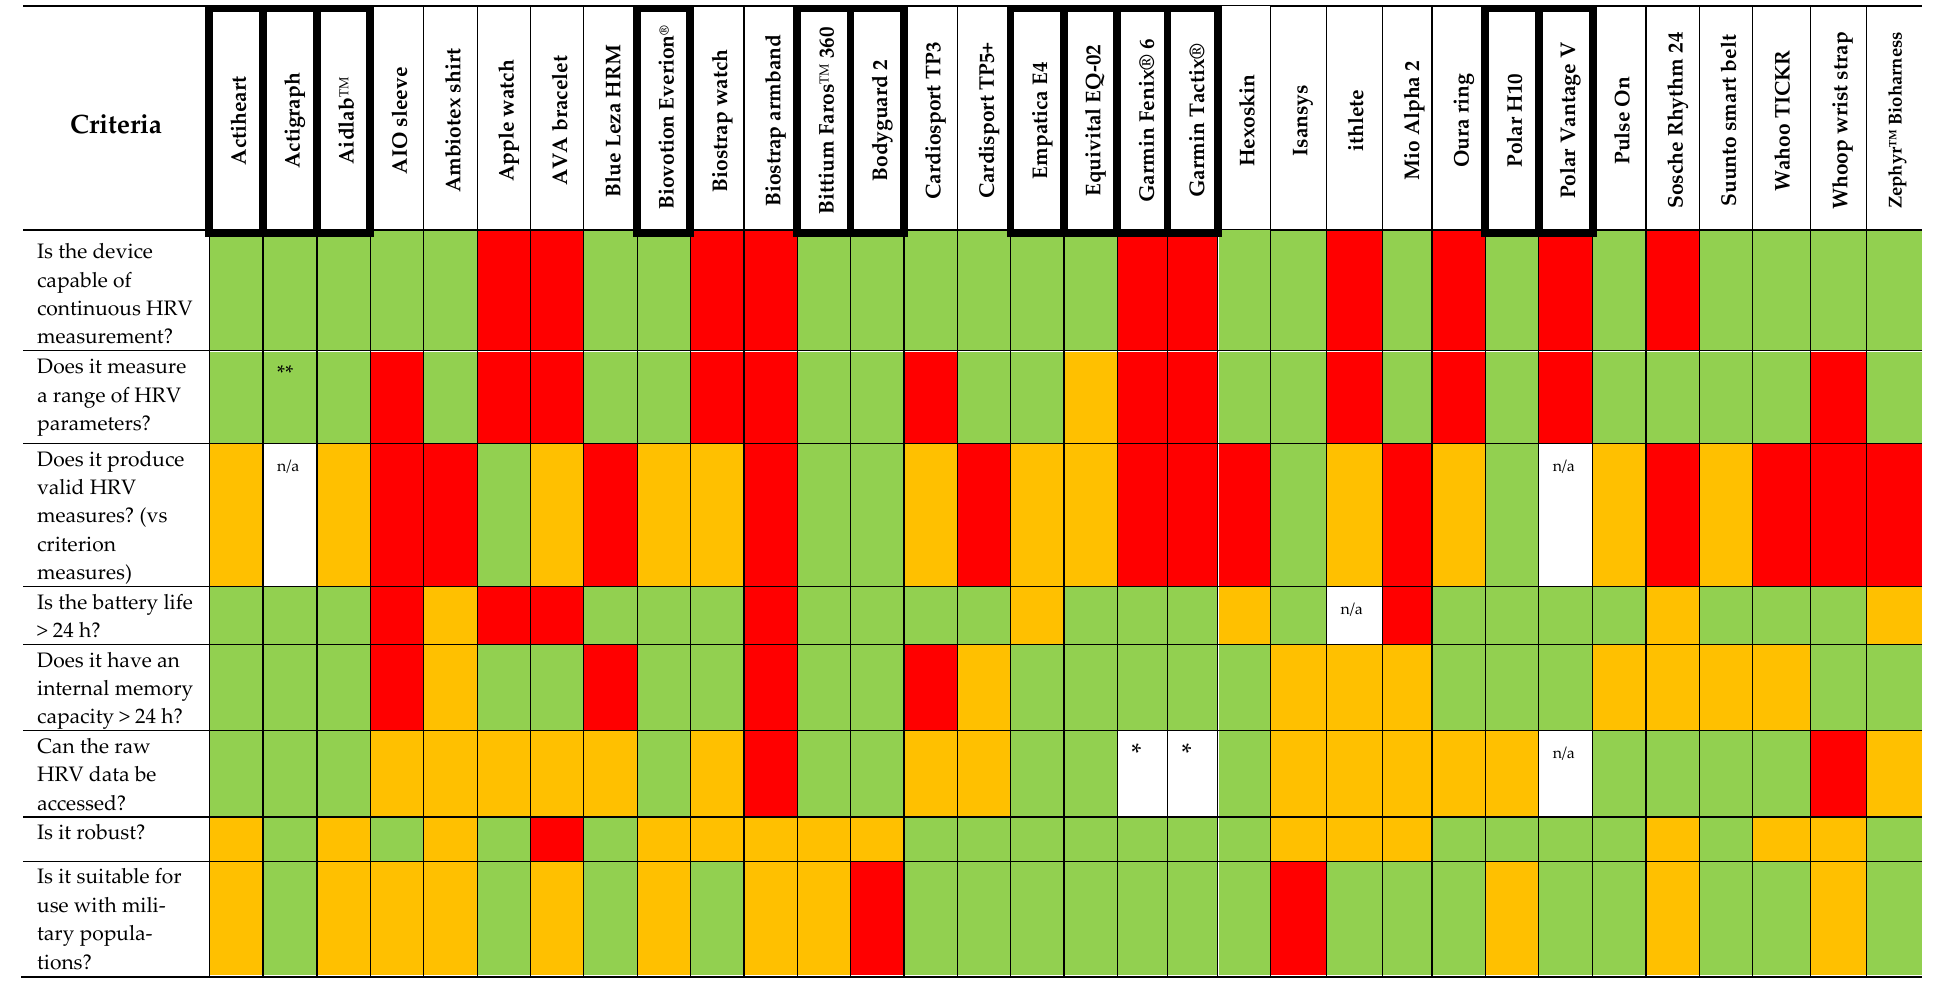
Table 2. Scoring matrix for each wearable device based on down-select criteria from Table 1 (device names highlighted in bold were down-selected).